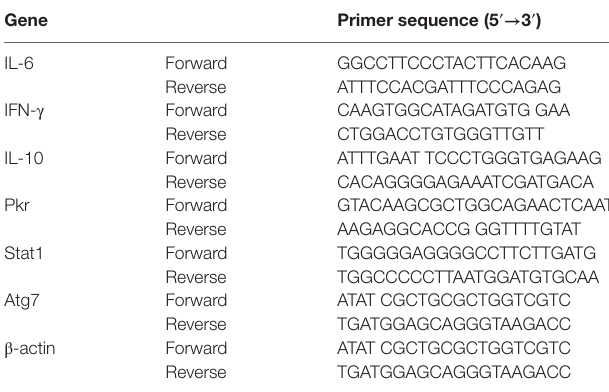
TaBle 1 | Nucleotide sequences of primers used for RT-PCR. gene Primer sequence (5 ′→ 3 ′